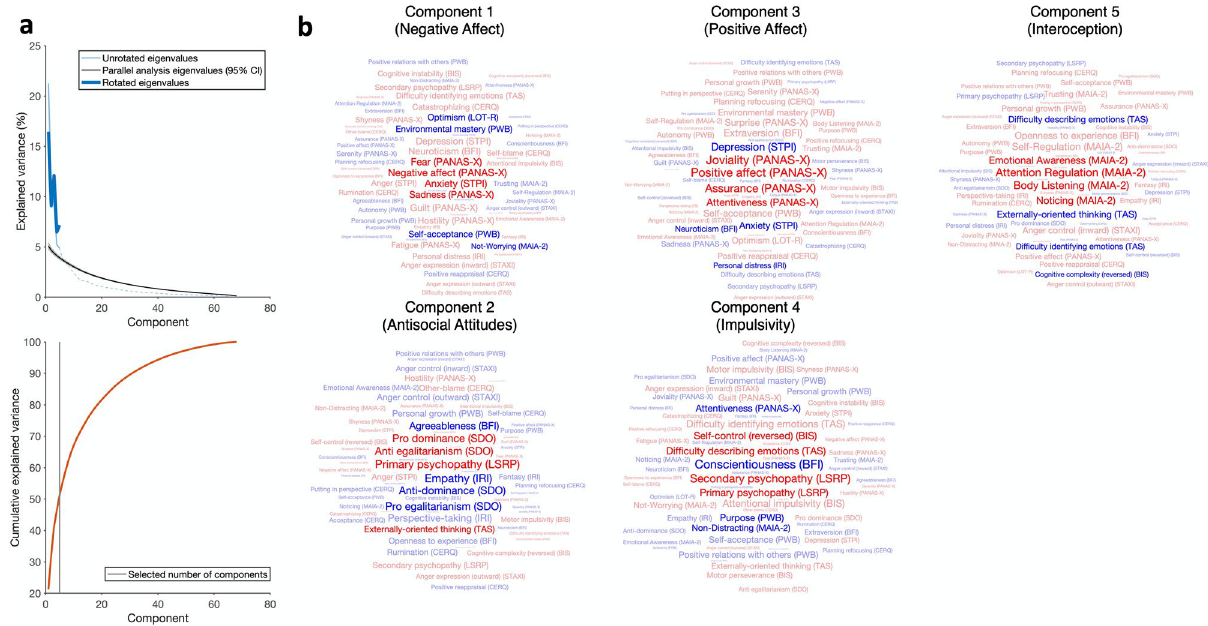
Figure 1. Latent dimensions of personality uncovered using PCA and used in the linear modelling procedure. ( a ) Eigenvalue plot showing the distribution of eigenvalues by component. Light blue line shows the unrotated eigenvalues; the dashed part reflects eigenvalues not significant following the permutation test. Black line shows the eigenvalues from the permutation test and the 95% confidence interval of these (grey shading). Dark blue shows the eigenvalues of the components following quartimax rotation. ( b ) Loadings of all significant components (determined by the permutation test). The size of the word corresponds to the magnitude of the loading, and red words reflect positive loadings while blue words reflect negative